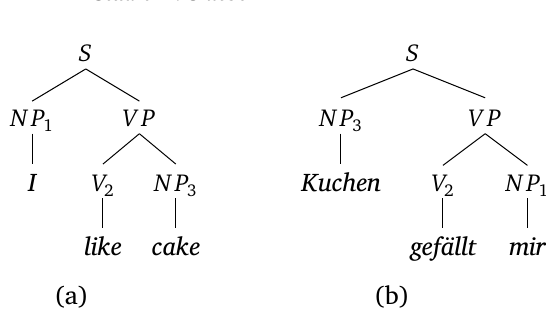
Example of local rotation in language translation divergence. Corresponding nodes are marked with matched